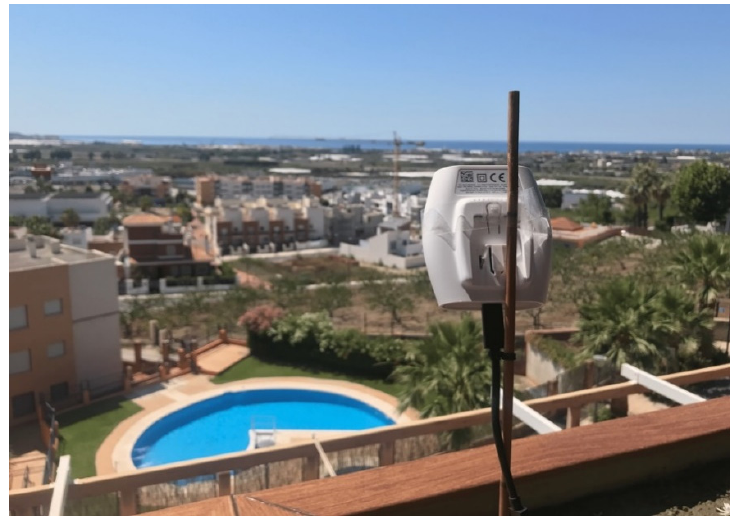
Figure 16. Position of the Gateway.